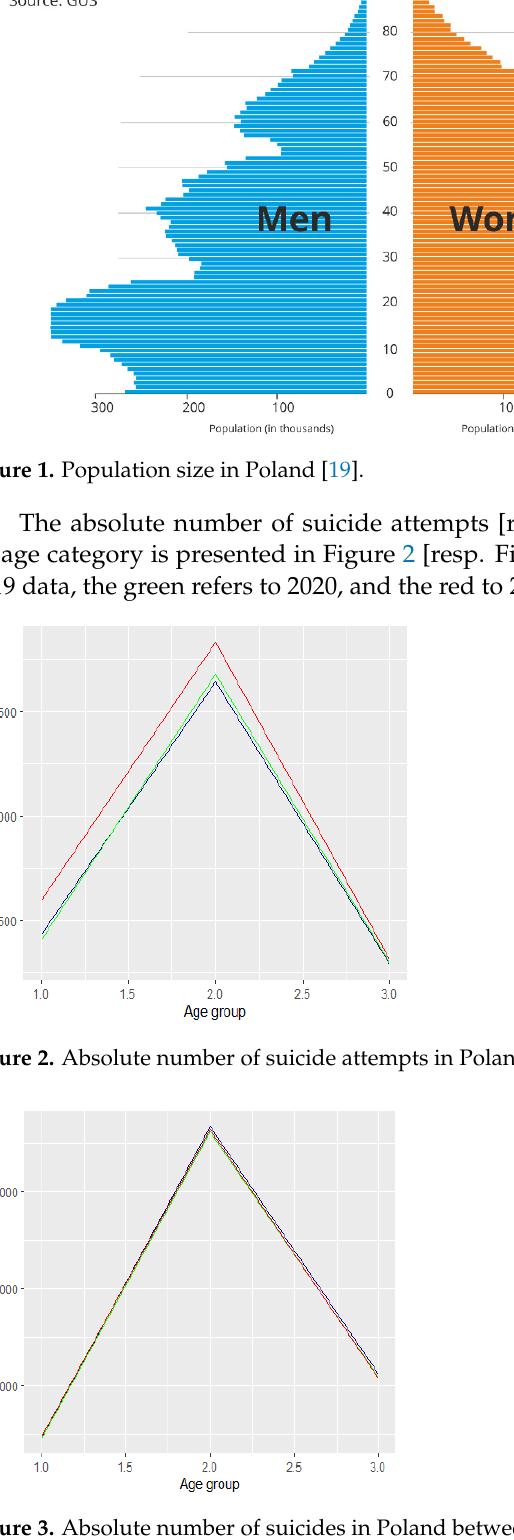
Figure 3. Absolute number of suicides in Poland between 2019 and 2021.